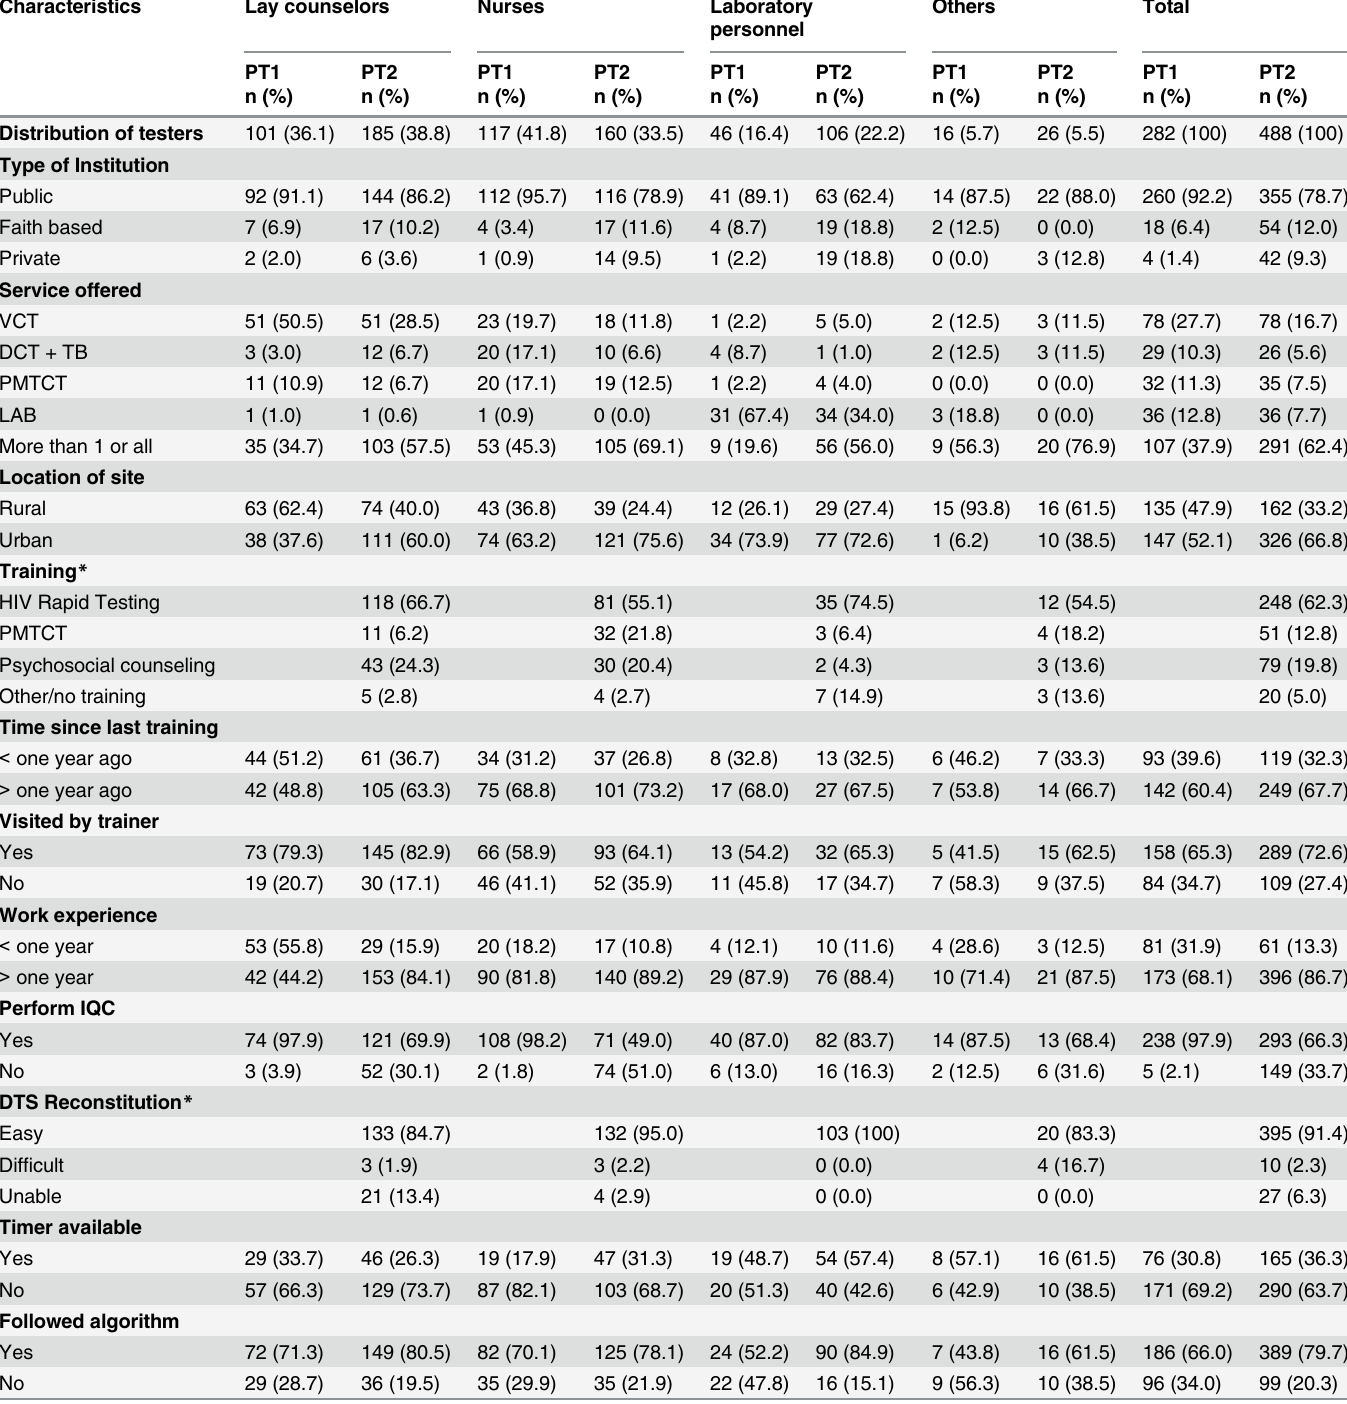
Table 1. General background and proficiency testing characteristics by tester